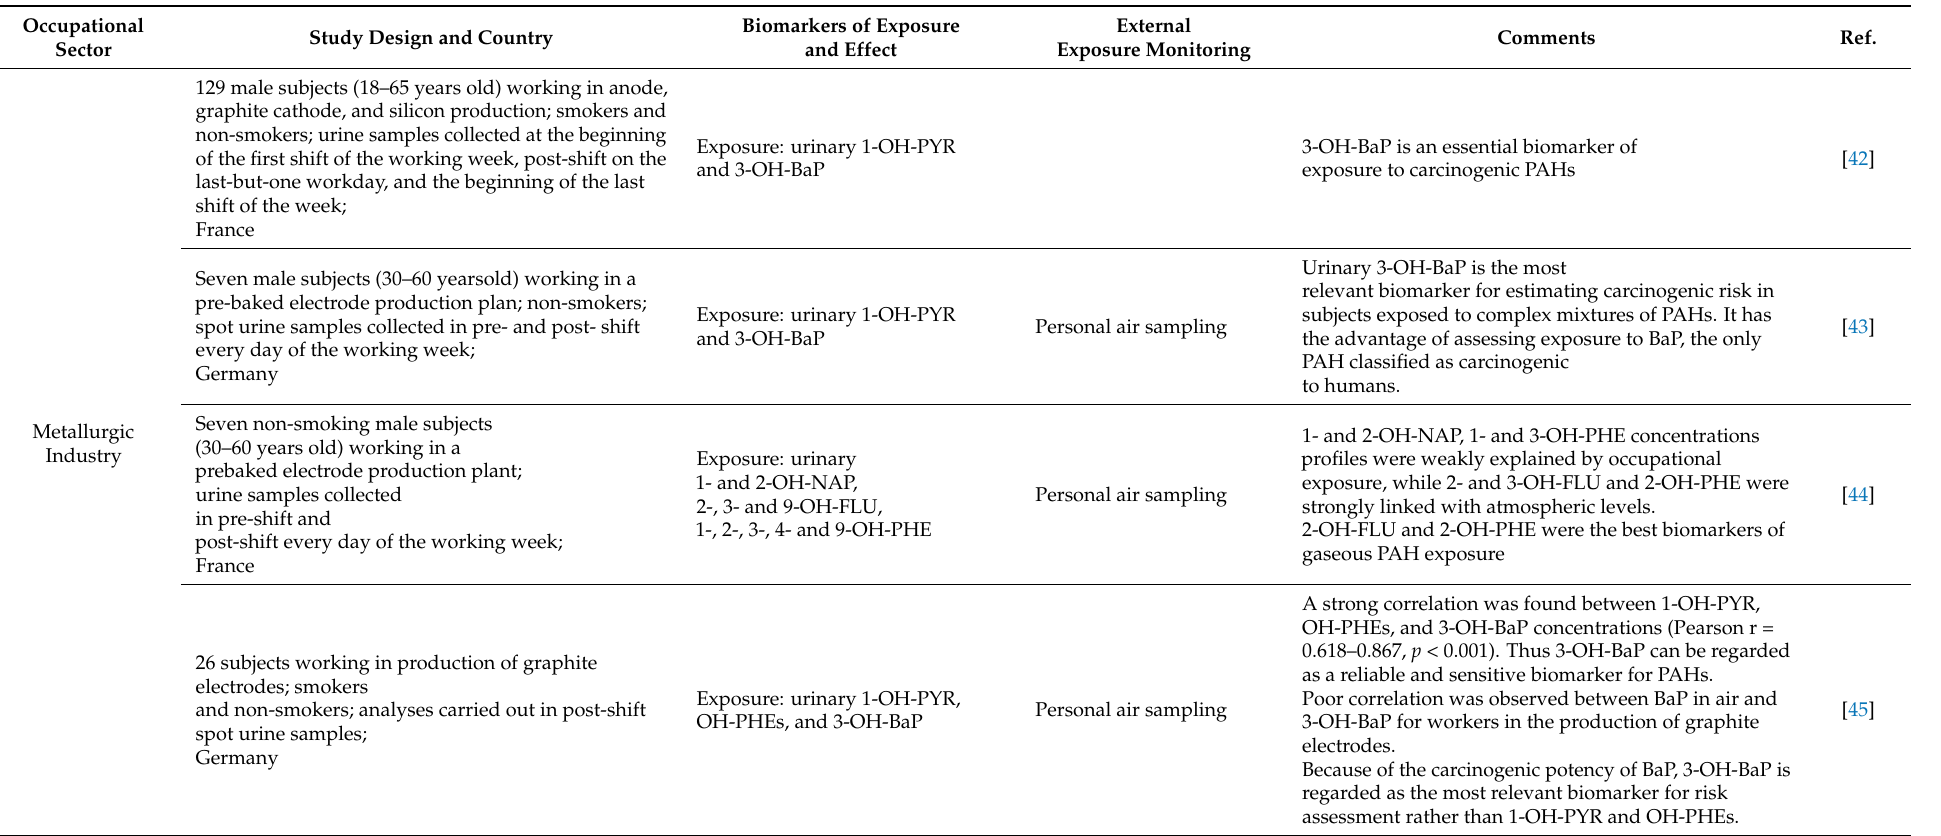
Table 4. Summary of exposure biomarkers identified in occupational exposure to PAHs as reported in the studies of interest to the present